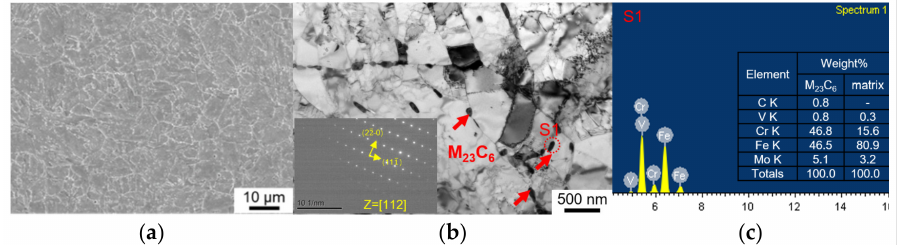
Figure 1. Microstructure of the T91 specimens: ( a ) SEM and ( b ) TEM with corresponding SADP of S1, and ( c ) EDS results of S1 before shot peening.